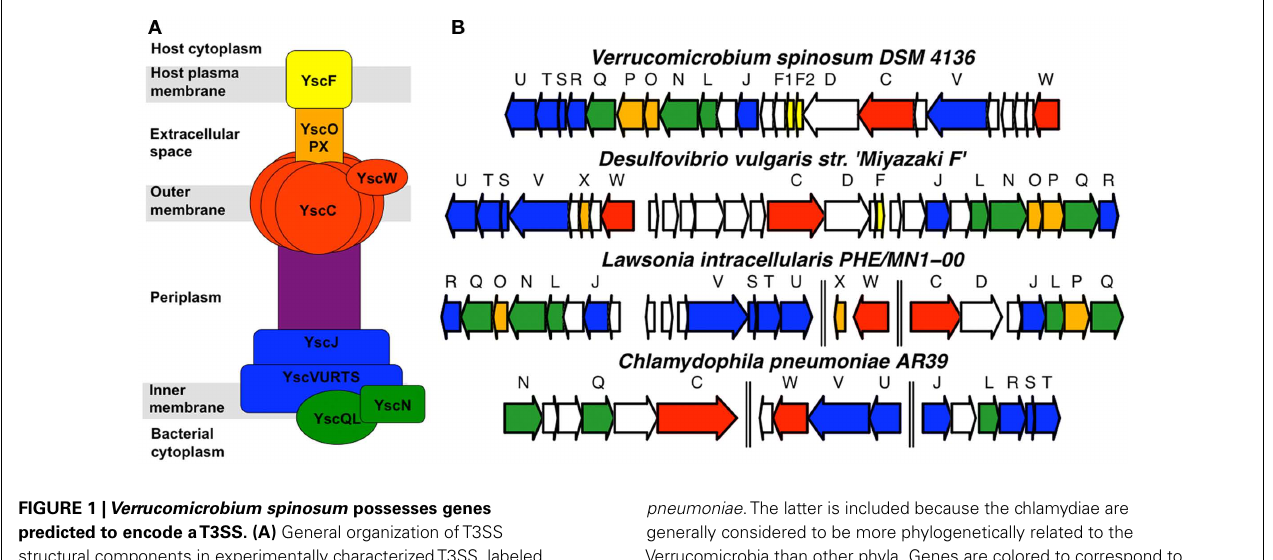
FIGURE 1 | Verrucomicrobium spinosum possesses genes predicted to encode aT3SS. (A) General organization ofT3SS structural components in experimentally characterizedT3SS, labeled according to the Yersinia T3SS nomenclature. (B) Organization of predictedT3SS structural genes in the genomes of V. spinosum , Desulfovibrio vulgaris , Lawsonia intracellularis , and Chlamydophila